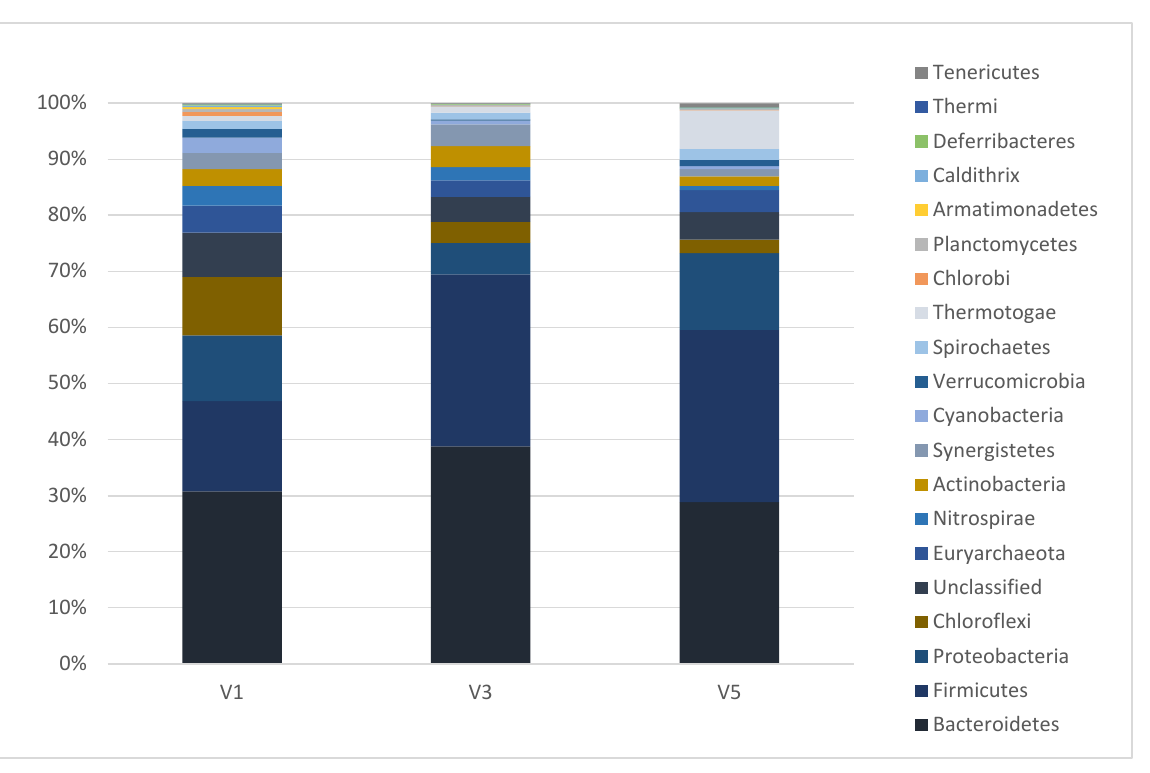
Figure 6. The abundance of phyla in anaerobic granular sludge in V1, V3, and V5 in stage 1. The abundance of Archaea in the anaerobic granular sludges was 4.85%, 2.95%,